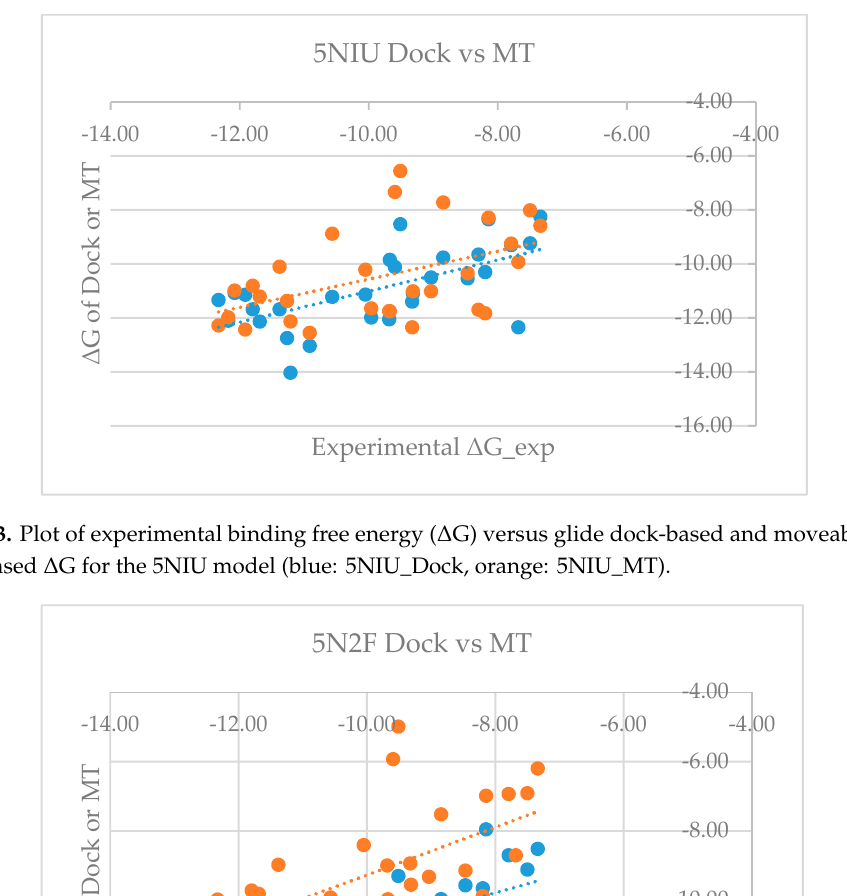
Figure 3. Plot of experimental binding free energy ( Δ G) versus glide dock-based and moveable-type (MT)-based Δ G for the 5NIU model (blue: 5NIU_Dock, orange: 5NIU_MT).